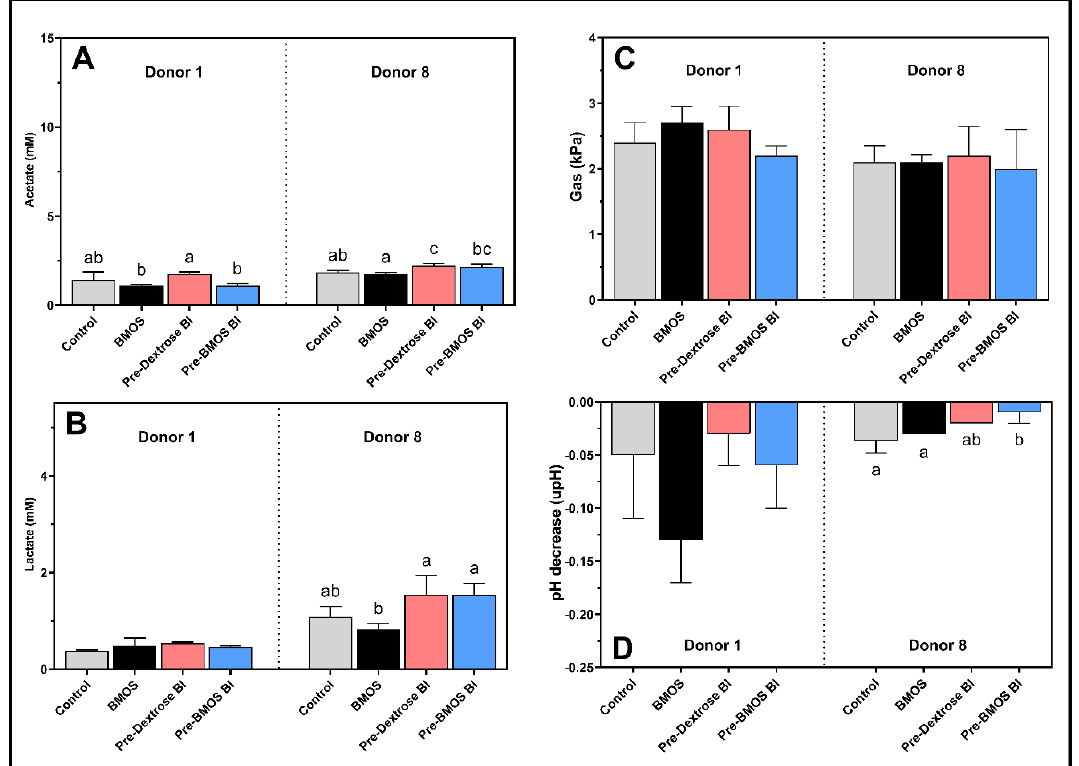
Figure A2. Mean ( ± standard deviation) microbial metabolic activity in terms of acetate production (mM) ( A ), lactate production (mM) ( B ), gas production (kPa) ( C ), and pH decrease (upH) ( D ) upon 6 h of fermentation by the infant fecal microbiota of Donors 1 and 8 after supplementation of 3 di ff erent formulations versus a blank control (Control, n = 3). Formulations contained either 5 g / L BMOS or 1.5 × 10 7 CFU / mL of B. lactis previously grown on either Dextrose (Pre-Dextrose Bl, n = 3) or BMOS (Pre-BMOS Bl, n = 3). Significant di ff erences between the di ff erent formulations within each donor are indicated with di ff erent letters (a, b, c) as tested with a one-way ANOVA with Tukey’s HSD post hoc test ( p < 0.05). In contrast, when at least one letter is shared between two treatments, there was no significant di ff erence between these groups.